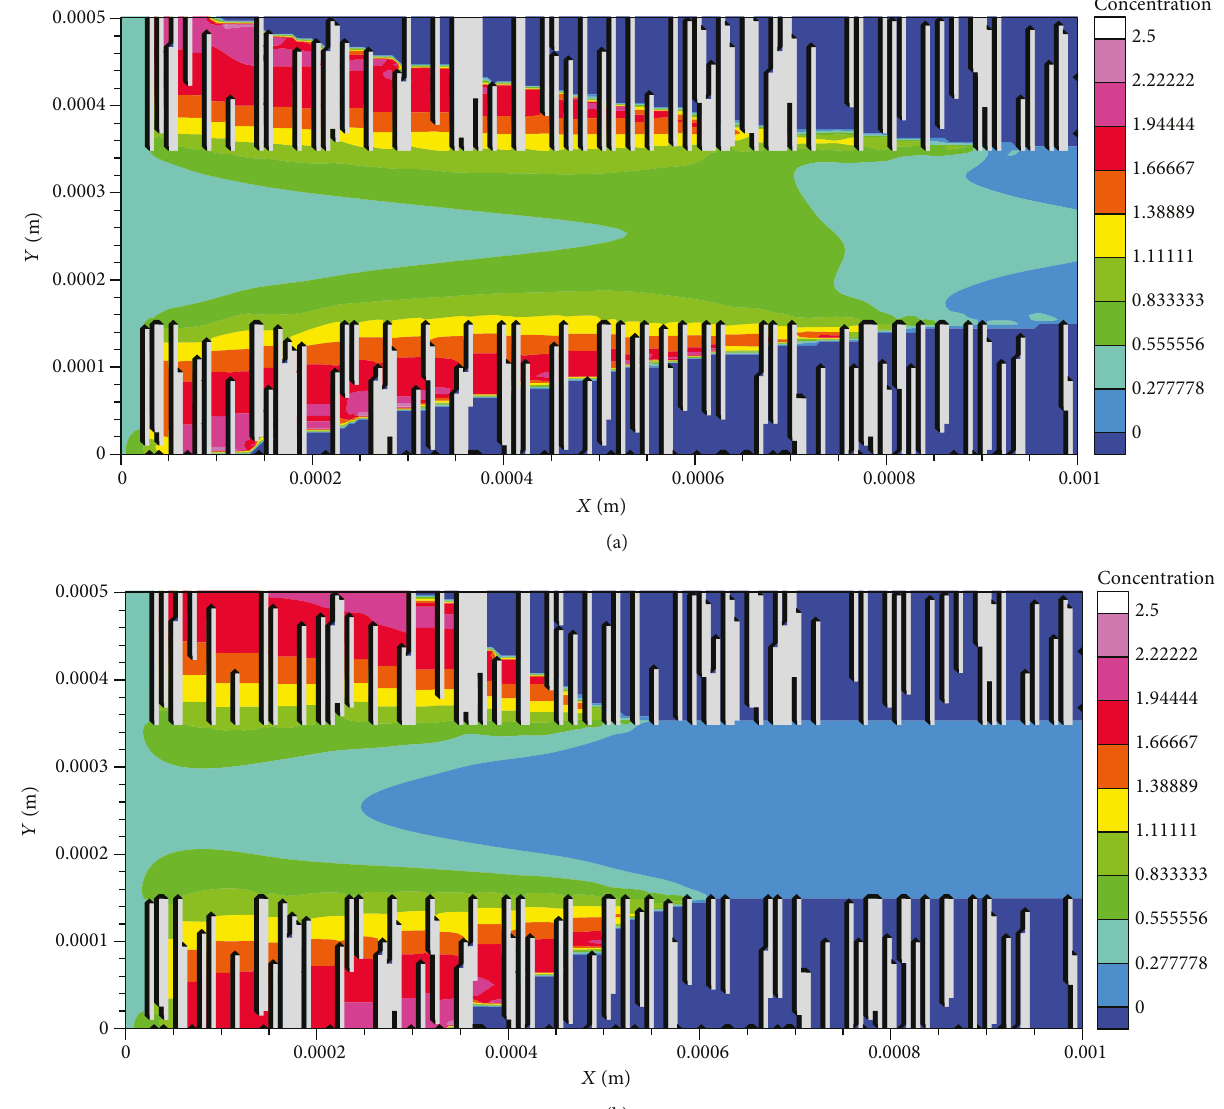
Figure 11: Concentration (mol/L) of species A when (a) Pe =26 and Da =20 and (b) Pe =0.026 and Da=20. In both (a) and (b), porosity (aq) (after dissolution) is near 0.58 but permeability (after dissolution) is 1.42 × 10 − 9 m 2 for (a) and 1.37 × 10 − 9 m 2 for (b). The nonreactive are representing reactive minerals are illustrated in light gray. The areas showing a zero concentration of species A (aq)